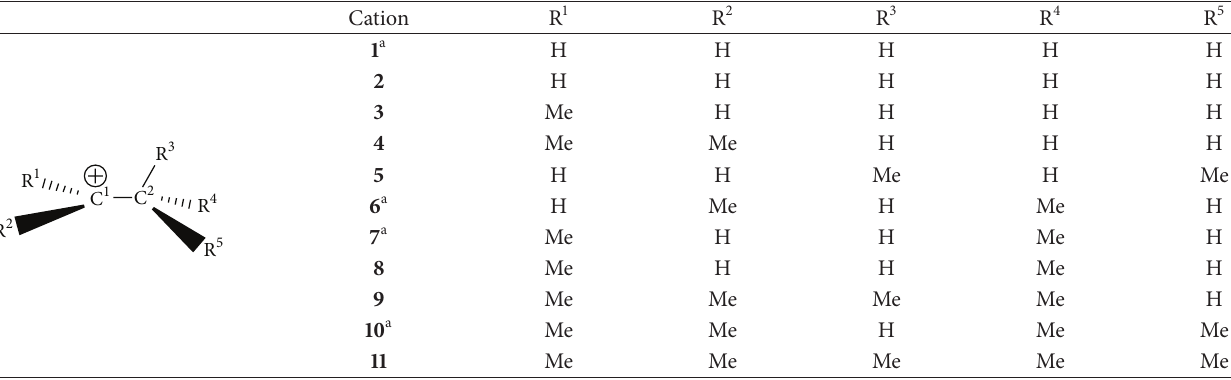
Table 1: Alkyl-substituted ethyl cations 1 – 11 .